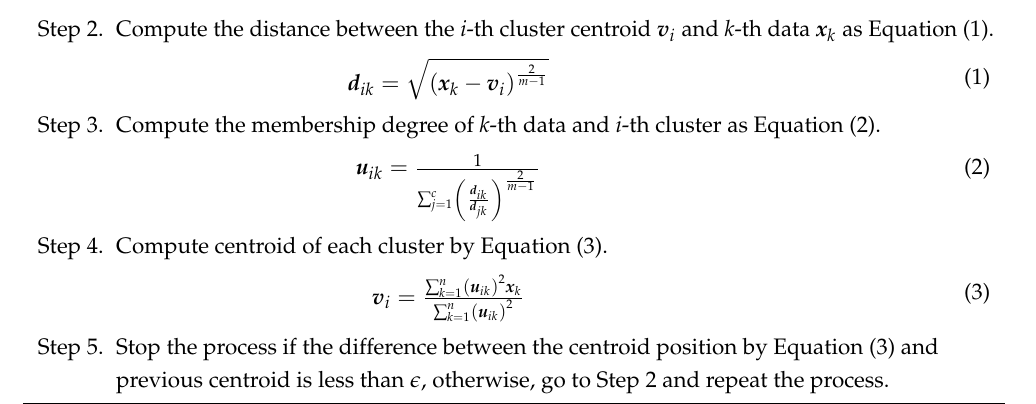
Algorithm 1. Fuzzy c ‐ means process.